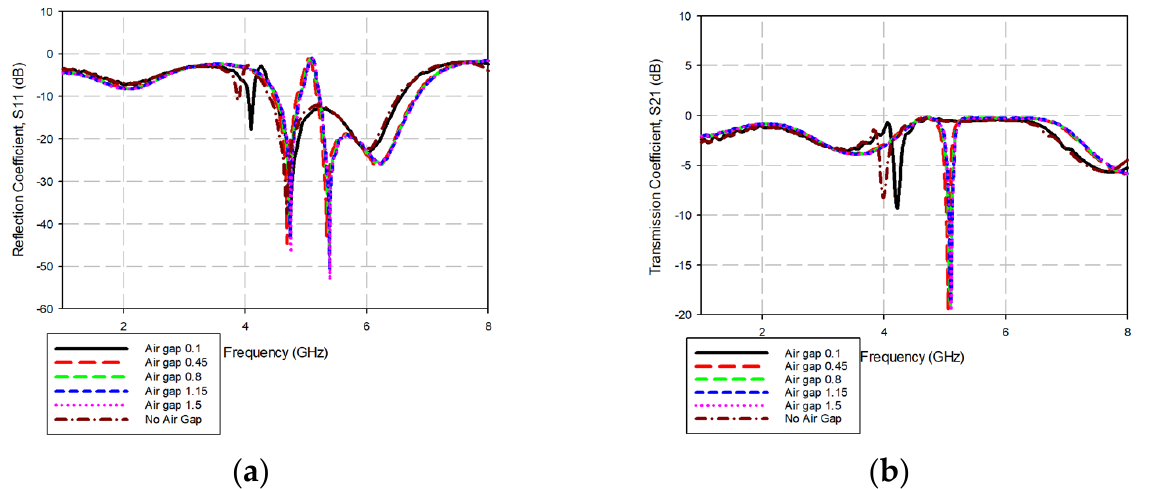
Figure 19. ( a ) Re fl ection coe ffi cient S11 of di ff erent thicknesses of MUT, ( b ) transmission coe ffi cient Figure 19. ( a ) Reflection coefficient S11 of different thicknesses of MUT, ( b ) transmission coeffi- S21 of di ff erent thicknesses of MUT. ( c ) Re fl ection coe ffi cient S11 of di ff erent widths of MUT, ( d ) cient S21 of different thicknesses of MUT. ( c ) Reflection coefficient S11 of different widths of MUT, transmission coe ffi cient S21 of di ff erent widths of MUT. ( d ) transmission coefficient S21 of different widths of MUT.